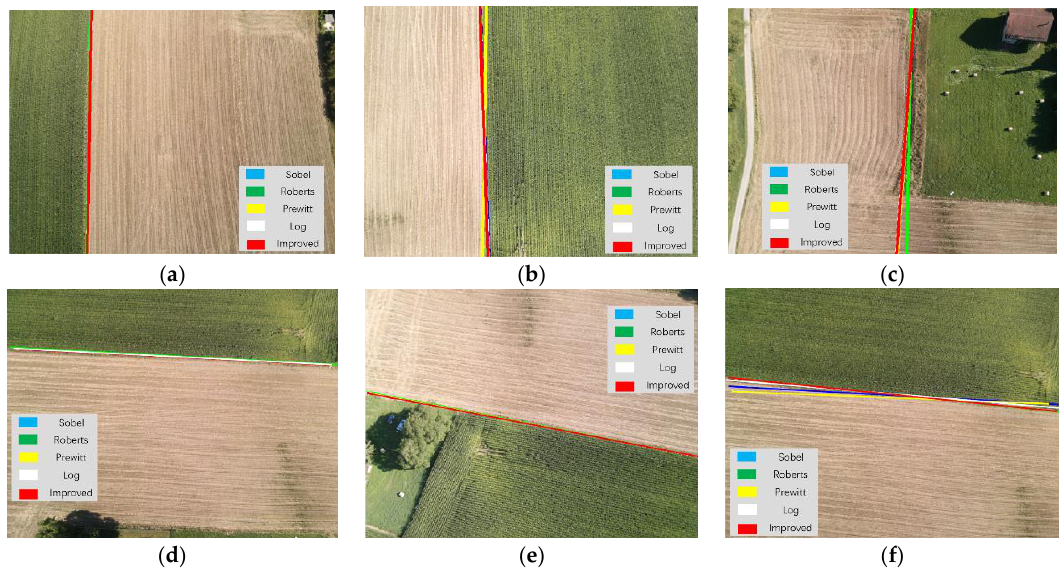
Figure 23. Comparison between the improved anti-noise morphology algorithm and existing operators using standard datasets. Red navigation lines were created using the improved anti-noise morphology algorithm: ( a ) first image sample; ( b ) second image sample; ( c ) third picture sample; ( d ) fourth picture sample; ( e ) fifth picture sample; ( f ) sixth picture sample.